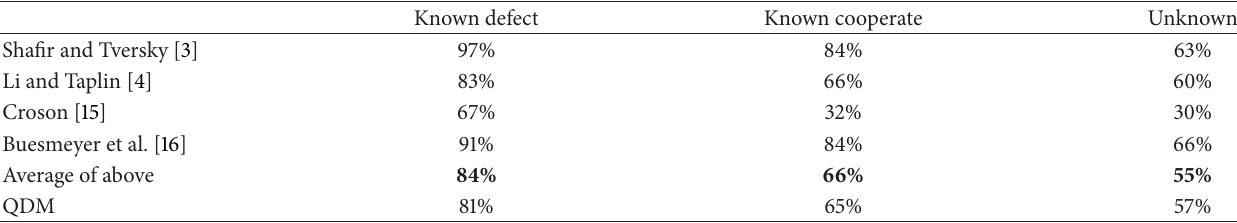
Table 2: Empirical studies and experiment results using QDM on Prisoner’s Dilemma (the probability indicates that Player 2 chooses “defect” by known “defect,” “cooperate,” or “unknown”).